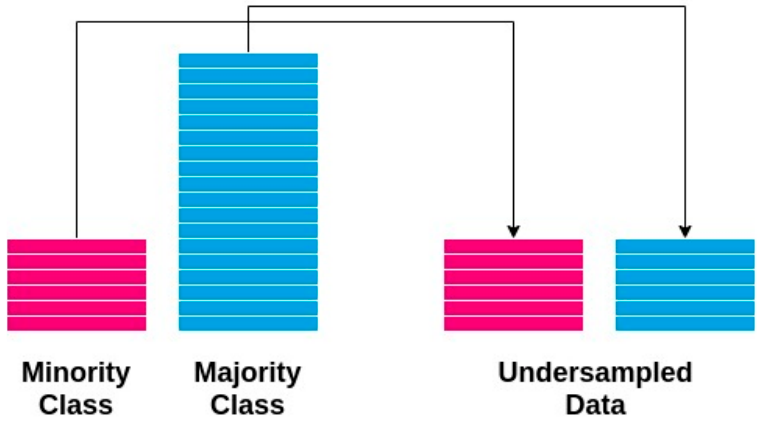
Figure 4. Illustration of SMOTE Oversampling for Imbalanced Classification. By interpolating between samples of the minority class that is close to one another, SMOTE generates new samples from the minority class.